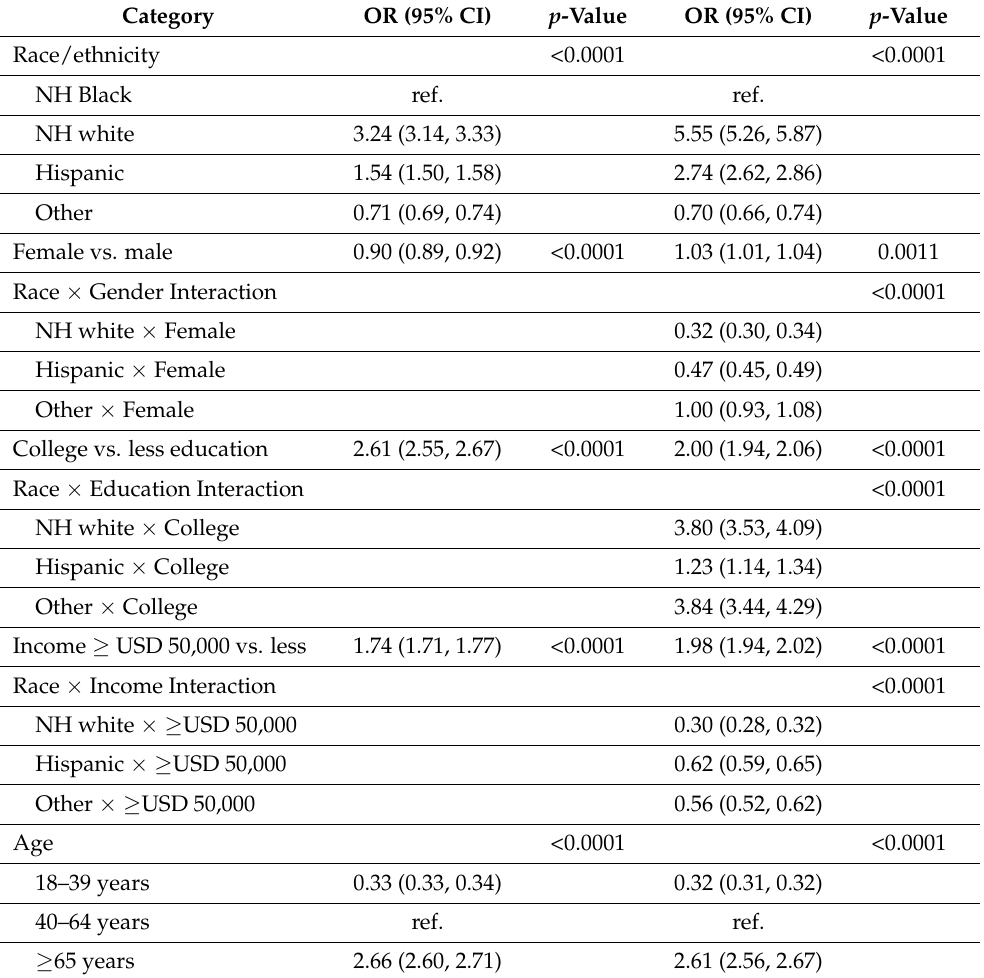
Table 2. Interactions between race/ethnicity and other sociodemographic variables in vaccine uptake among 784 Detroiters, June